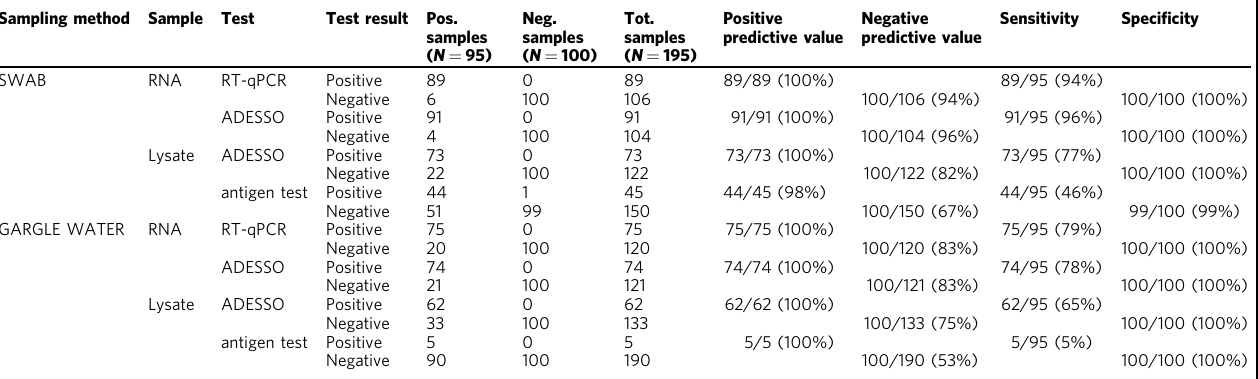
Table 1 Predictive values, sensitivity and speci fi city of ADESSO, Tib Molbiol RT-qPCR and RIDA QUICK SARS-CoV-2 antigen test on swab and gargle samples. Sampling method Sample Test Test result Pos.